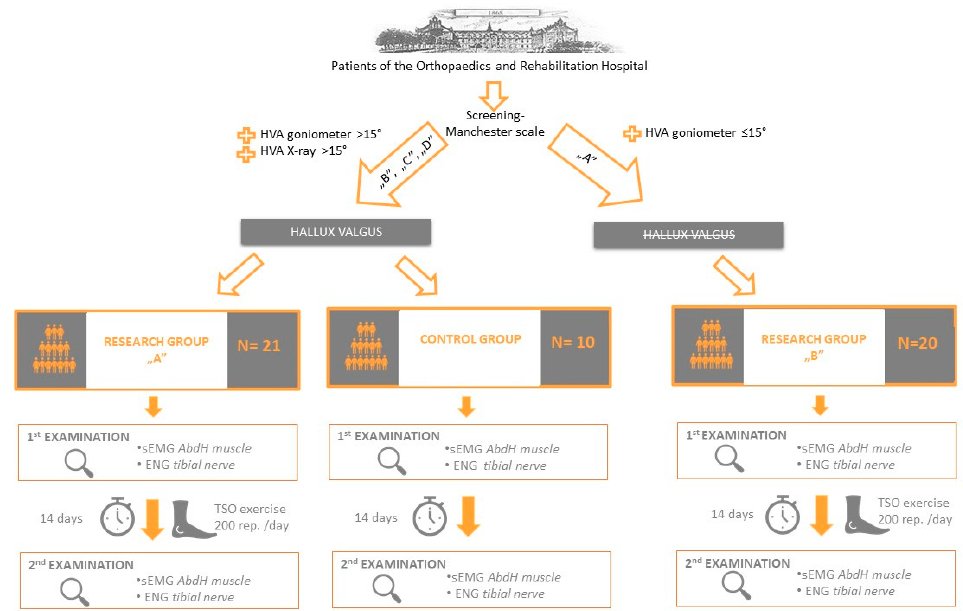
Figure 1. The design of the study (HVA—hallux valgus angle, 1st examination—first examination before exercise, 2nd examination—second examination after exercise, sEMG—surface electromyography, ENG—electroneurography, AbdH muscle—abductor hallucis muscle, TSO—toe spread out exercise, rep.—repetitions).